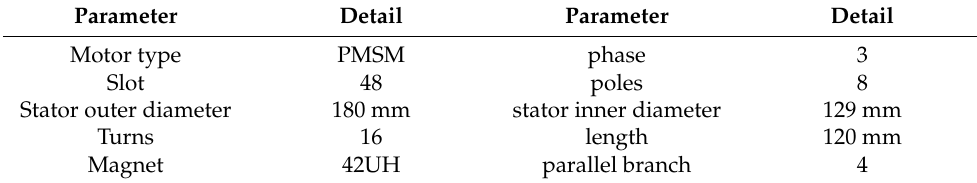
Figure 1. Topology structure of V-shaped, V + 1-shaped, and double-V-shaped rotors. Table 1. Units for magnetic